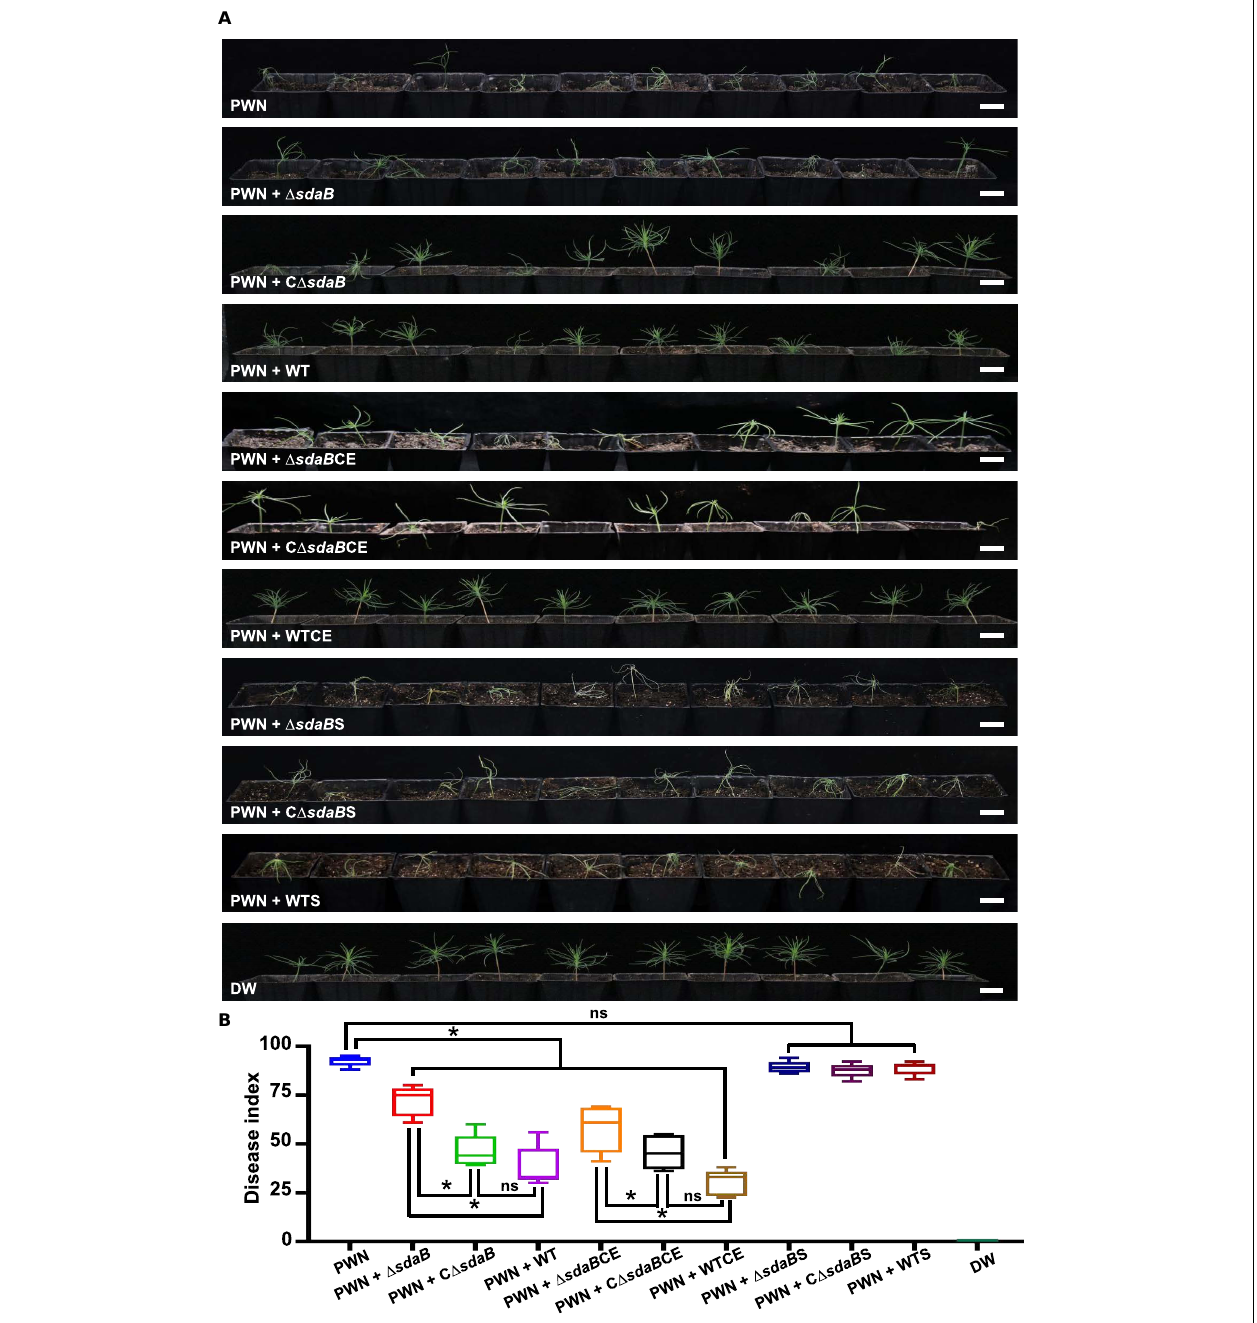
FIGURE 6 | Disease-suppressing effect of E. ludwigii AA4 against PWD caused by B. xylophilus . (A) Biocontrol effect of E. ludwigii AA4 and its sdaB gene knock-out mutant against PWD on 1-month-old P. sylvestris seedlings. (B) Severity of PWD on 1-month-old P. sylvestris seedlings treated with PWN jointly with wild-type AA4 or AA4 (cid:49) sdaB . The horizontal bars within boxes represent the median. The tops and bottoms of boxes represent the 75th and 25th quartiles, respectively. The upper and lower whiskers extend from 75th quartiles to the maxima and from the 25th quartiles to the minima, respectively. The asterisks indicate that differences among the means represented by the boxes are statistically significant (* p ≤ 0.0345). Two-tailed t -test (GrapPad Prism 8) was used for the analysis. PWN, treatment with PWN alone; PWN + (cid:49) sdaB , joint treatment with PWN and AA4 (cid:49) sdaB ; PWN + C (cid:49) sdaB , joint treatment with PWN and AA4C (cid:49) sdaB ; PWN + WT, joint treatment with PWN and wild-type AA4; PWN + (cid:49) sdaB CE, joint treatment with PWN and AA4 (cid:49) sdaB cell extract; PWN + C (cid:49) sdaB CE, joint treatment with PWN and AA4C (cid:49) sdaB cell extract; PWN + WTCE, joint treatment with PWN and wild-type AA4 cell extract; PWN + (cid:49) sdaB S, joint treatment with PWN and AA4 (cid:49) sdaB culture supernatant; PWN + C (cid:49) sdaB S, joint treatment with PWN and AA4C (cid:49) sdaB culture supernatant; PWN + WTS, joint treatment with PWN and wild-type AA4 culture supernatant; DW, treatment with distilled water (scale bars: 2 cm).